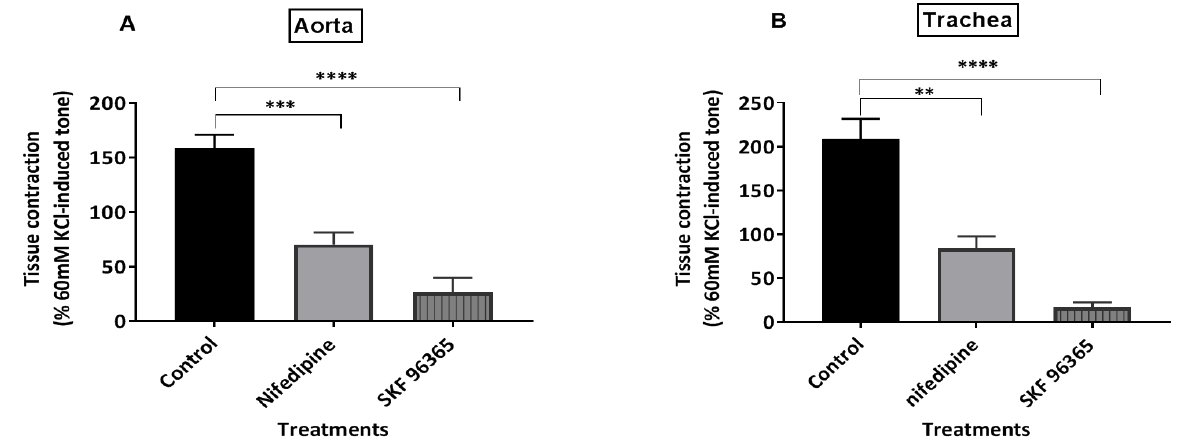
Figure 2: Effect of nifedipine and SKF 96365 pre-incubation on maximal response (E max ) of (A) phenylephrine concentration response curve in rat aortic rings and (B) carbachol-concentration response curve in tracheal rings. Tissue responses have been expressed as a percentage of 60mM KCl-induced contraction and are shown as means ± SEM of 3 to 8 animals (unpaired t-test :** p <0.01, *** p <0.001, **** p